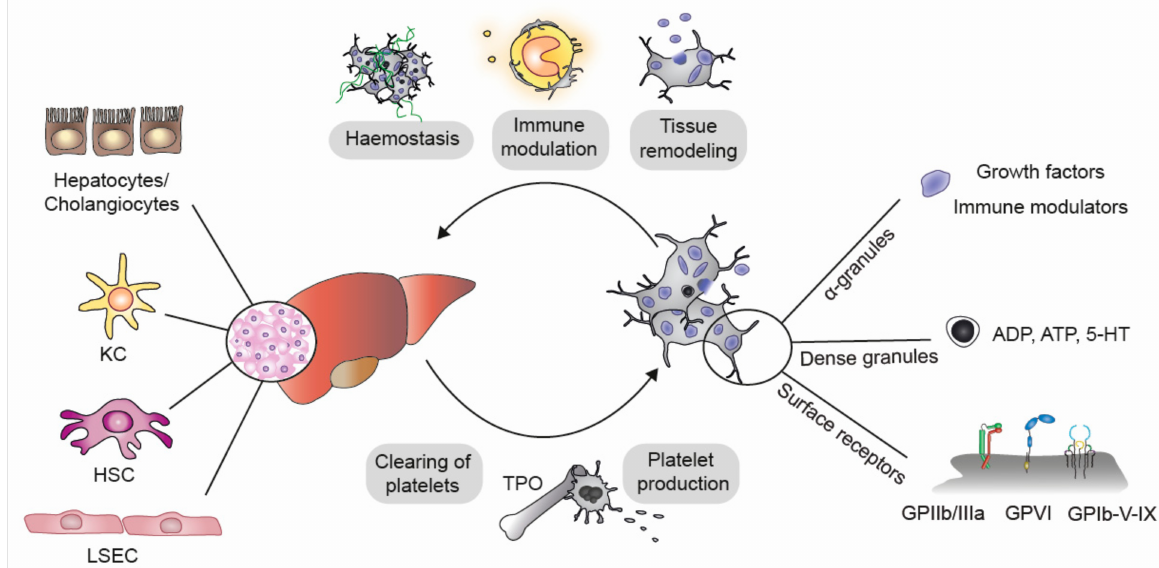
Figure 1. Interactions between liver and platelets. The liver consists of parenchymal (90% hepatocytes) and non-parenchymal cells (2–3% cholangiocytes, 2.5% liver sinusoidal endothelial cells [LSEC], 2% Kupffer cells [KC] and 1.4% hepatic stellate cells [HSC]) [7]. Parenchymal cells secrete thrombopoietin (TPO), which stimulates platelet production and maturation. The liver is further involved in platelet clearance. Platelets modulate liver functions by the release of α - and dense granules, which contain growth factors and immune modulators as well adenosine diphosphate (ADP), adenosine triphosphate (ATP) and serotonin (5-HT), respectively. Platelet surface receptors (GPIIb/IIIa, GPVI, GPIb-V-IV) allow interactions with hepatic cells and extracellular matrix components, which initiates tissue remodeling and hemostasis and promotes immune